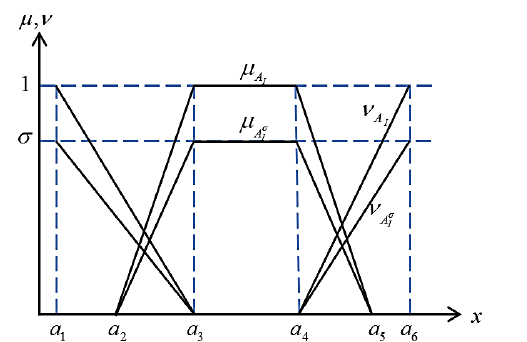
Fig. 6. Membershi p and non-membership functions of the weighted